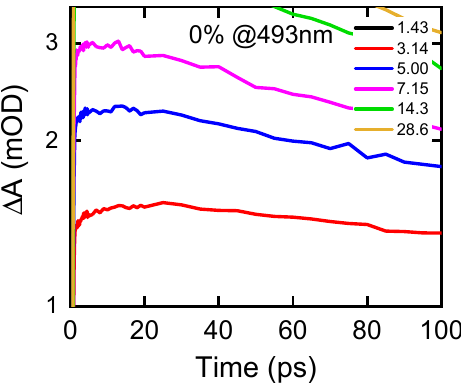
Figure 6. Time evolution of transient absorption at the peak of GSB band of the perovskite film without excess RbBr at intermediate excitation-pulse energy densities.